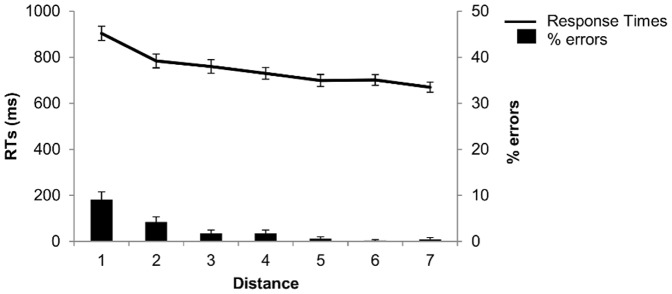
Response times and errors percentage for the numerical comparison task.Behavioral performances in number comparison task, as a function of numerical distance.